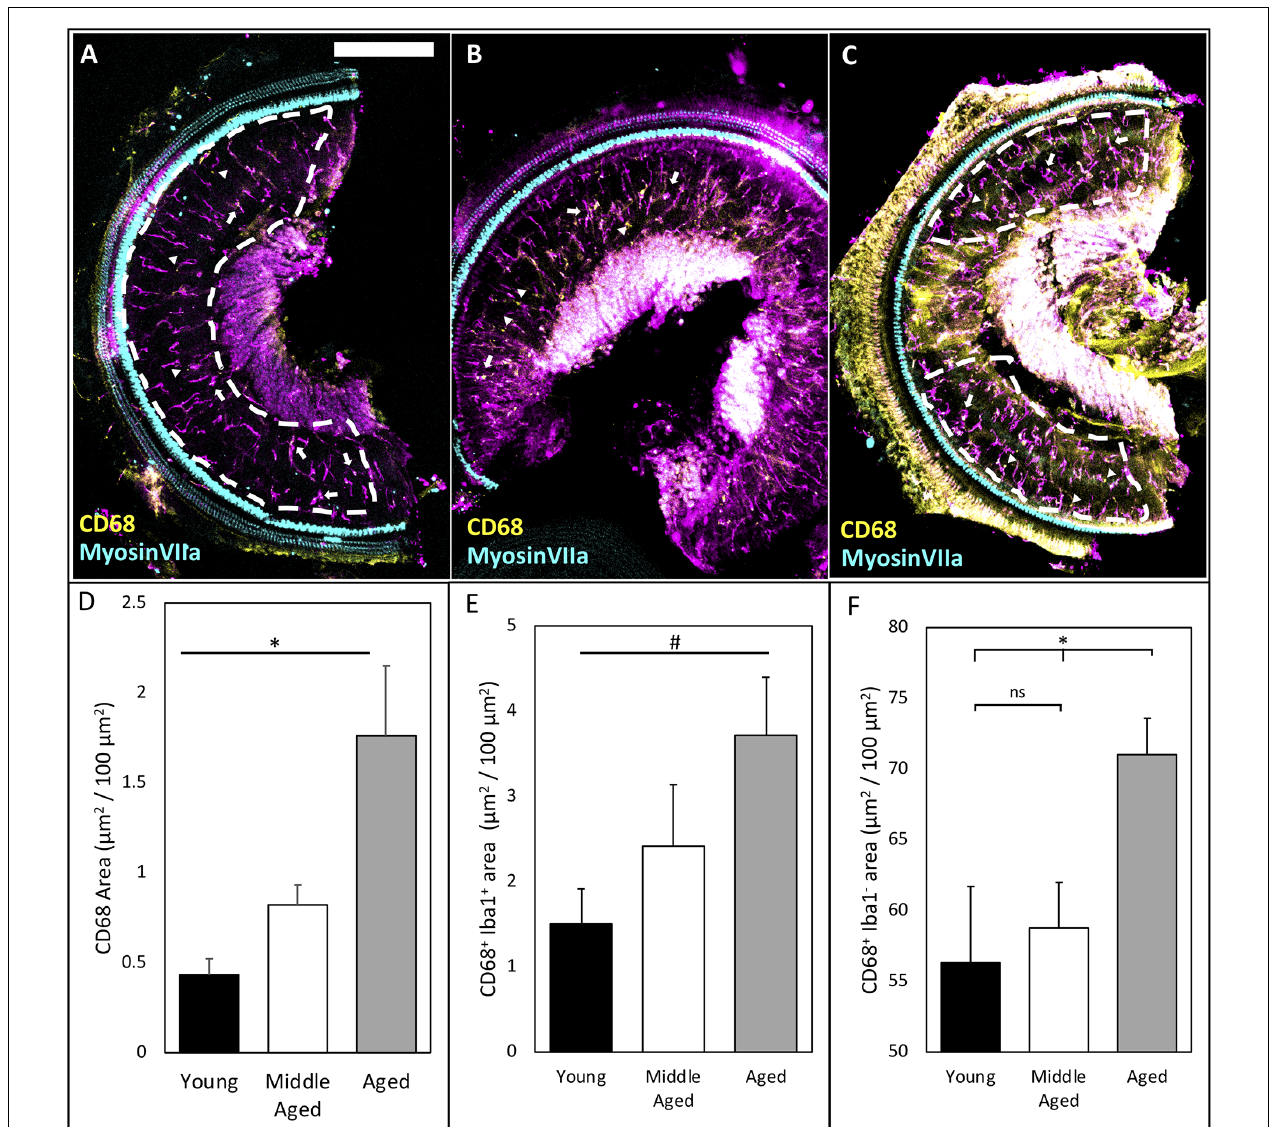
FIGURE 2 | CD68 levels increase in OSL across aging. (A–C) Representative images of CD68 labeling in the OSL (ROI indicated by white dashed line) of young, middle-aged, and aged mice. Note: occasionally the tectorial membrane was not completely removed adding noise in the signal. This noise was excluded from ROI analysis (see ROI in panel C ). Scale bar = 200 µ m. Arrows: indicate Iba1+ CD68 + macrophages. Triangles: indicate CD68 outside Iba1 + macrophages. (D) Quantification of CD68 shows significant increases across aging. ∗ p < 0.05. (E) Co-localization of CD68 and Iba1 shows a trend toward increases in